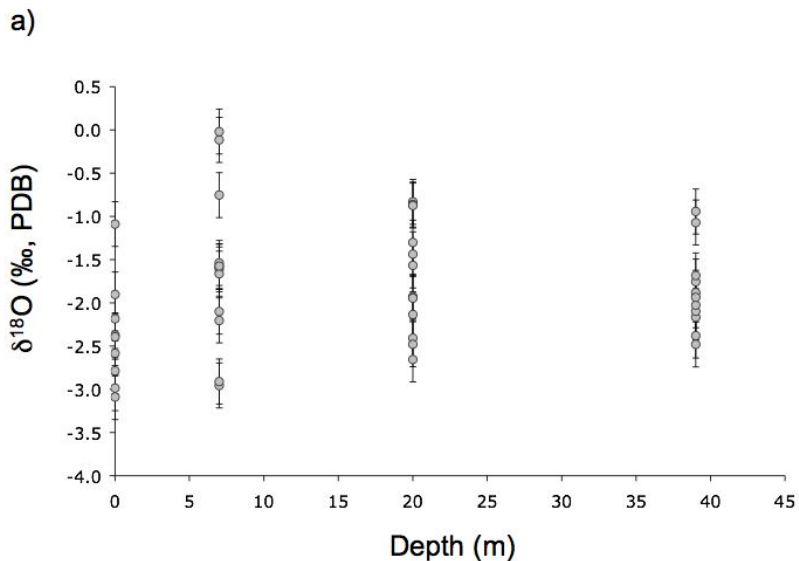
Figure 5. ( a ) δ 18 O values (‰, PDB) measured by SIMS in the inner nacre layer of each shell versus the depth (m) at which the organisms grew. Each error bar takes into account the internal error and the external reproducibility (see text for more details); ( b ) Average δ 18 O (‰, PDB) for each shell versus depth. The error bars represent the standard deviation (±1 σ ) of the δ 18 O measurements in each shell (n = 9 to 12, depending of the sample). No influence of the depth on δ 18 O values was